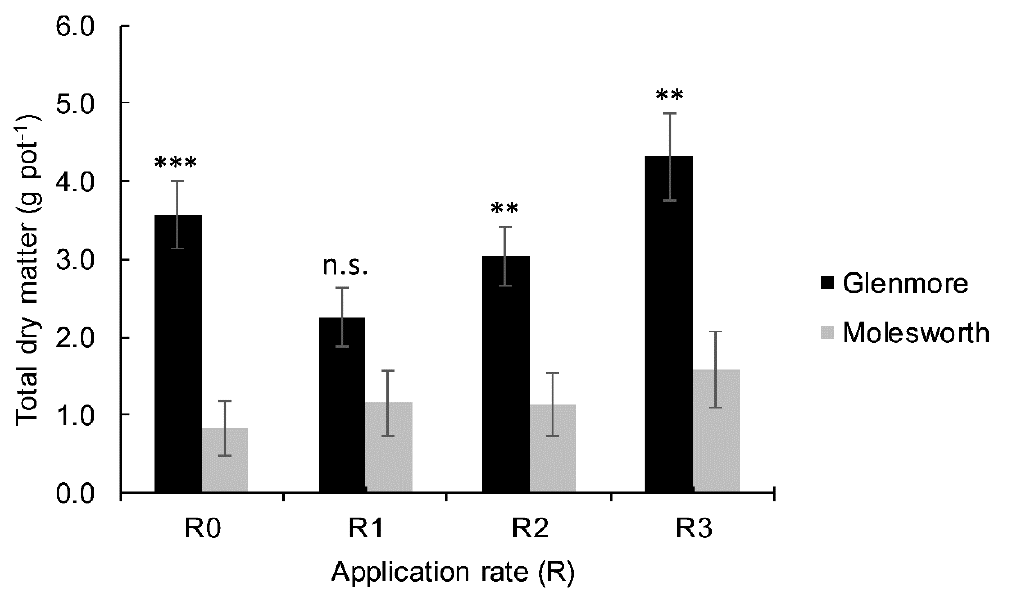
Figure 1. Total dry matter yield (g pot − 1 , n = 8) of lucerne ( Medicago sativa ) after six-month growth period under two di ff erent soils: Molesworth (MO) and Glenmore (GM), as a ff ected by four rates of phosphogypsum (PG) across two lime treatments (0 and 2 t ha − 1 ). Error bars indicate standard errors ( ± SEM, n = 8). Means of TDM for GM and MO per rate (R0 to R3) were separated using a two-sample t -test at 5%. Asterisks above bars indicate the level of significance in the di ff erence between the two soils within each rate of PG (** p < 0.01, *** p < 0.001, n.s. not significant). Table1. Summary of theanalyses of variance toevaluate the e ff ect of soiltype, lime andphosphogypsum (PG) or soluble fertilizer (PG) and their interactions on total dry matter yield of lucerne (TDM, g pot − 1 ). Factors Phosphogypsum (PG) Soluble Fertilizer (PS) Soil (S) *** *** Lime (L) *** *** Rate (R) *** n.s. S * L n.s. n.s. S * R ** n.s L * R n.s. n.s S * L * R n.s.